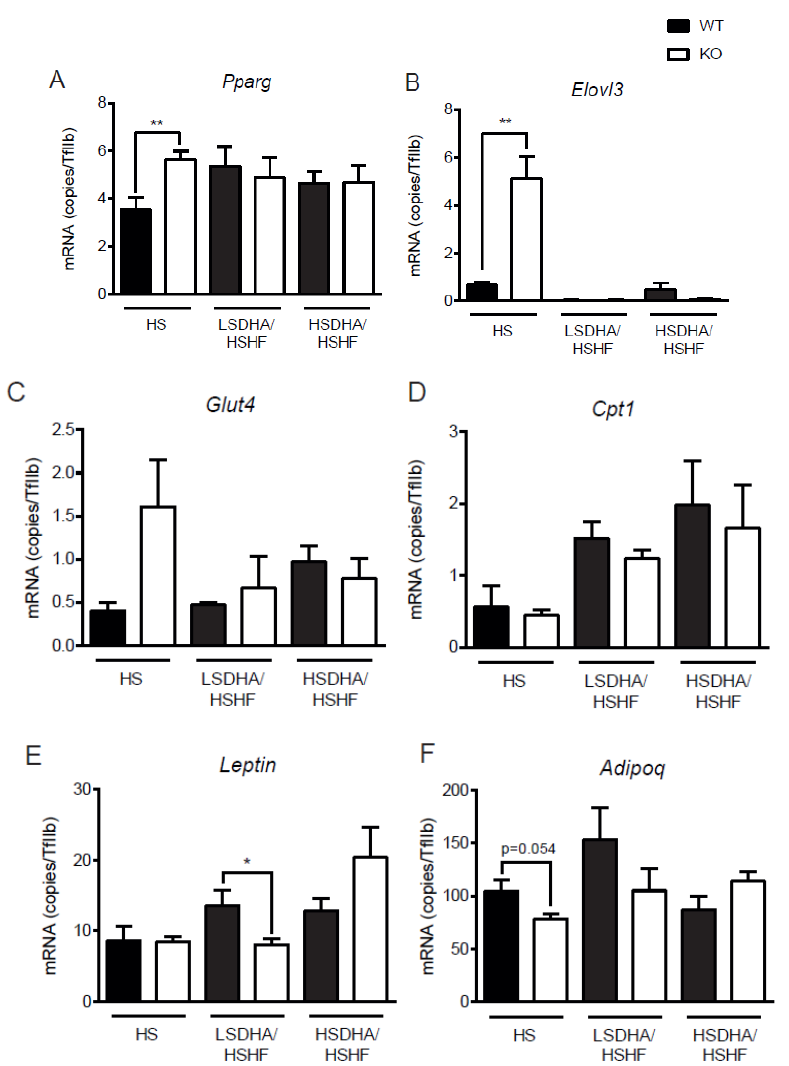
Figure 7. Dietary sucrose content a ff ects expression of genes involved in the accumulation of fat in the epididymal white adipose tissue of Elovl2 - / - mice. Relative epididymal white adipose tissue gene expression of PPAR γ ( A ), Elovl3 ( B ), Glut4 ( C ), Cpt1 ( D ), leptin ( E ), and adiponectin ( F ) in wild-type and Elovl2 - / - mice fed low-sucrose DHA-enriched diet, followed by high-sucrose, high-fat diet (LSDHA / HSHF); high-sucrose DHA-enriched diet followed by high-sucrose, high-fat diet (HSDHA / HSHF) or mice that were just fed high-sucrose diet (HS). mRNA levels relative to TFIIB expression. Results shown are means of ± SEM of four mice. * p < 0.05 and ** p < 0.01 versus WT by paired Student’s t -test.